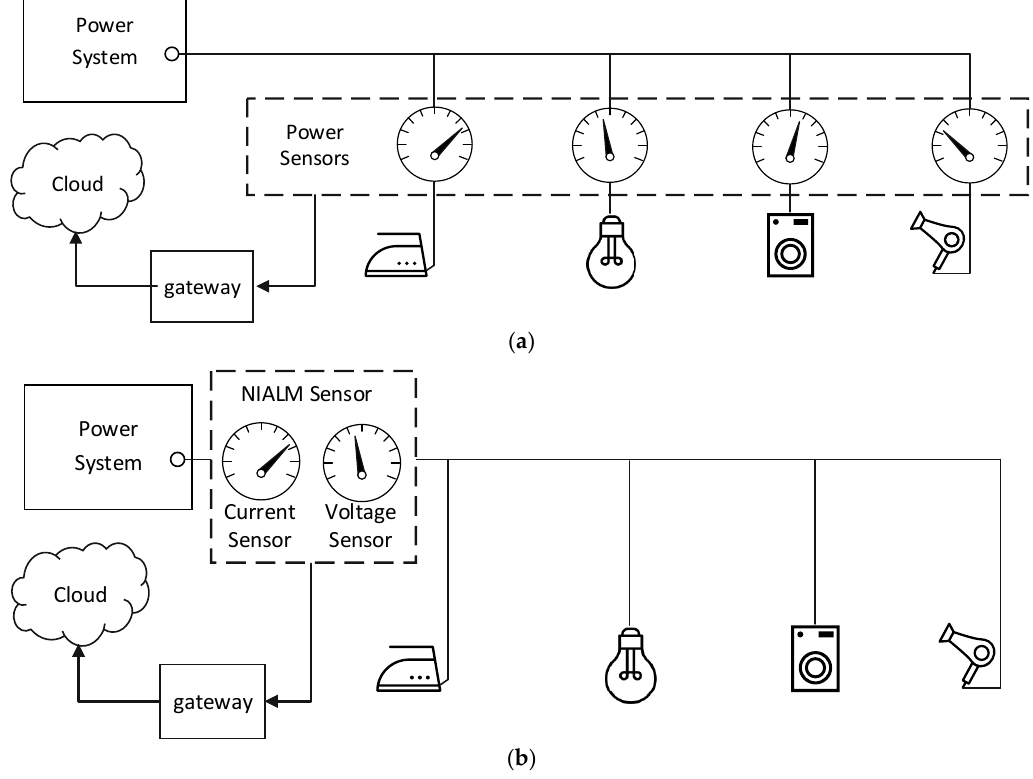
Figure 1. Appliance load monitoring systems: ( a ) intrusive appliance load monitoring (IALM); ( b ) nonintrusive appliance load monitoring (NIALMS).